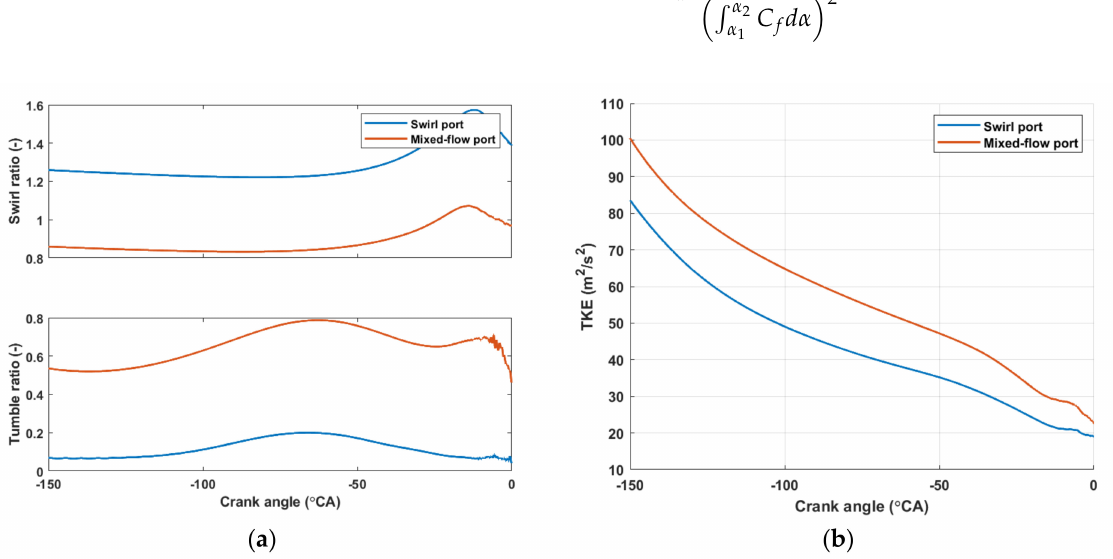
Figure 4. The comparisons of the SIP and MFIP in ( a ) SR, TR, and ( b ) TKE. In the early stage of compression before 50 ◦ CA bTDC, the SR values of both intake ports remain almost constant. As the compression stroke progresses, the cylinder